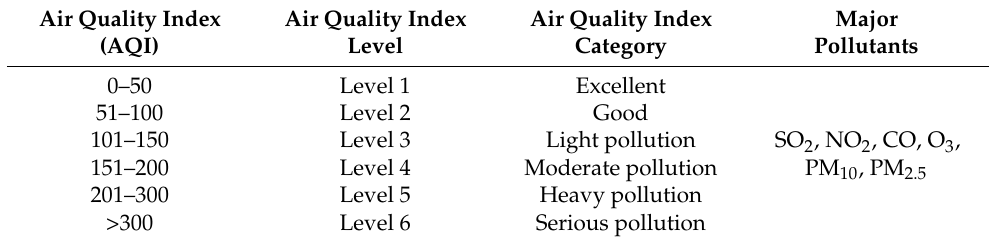
Table 1. The basic characteristics of Air Quality